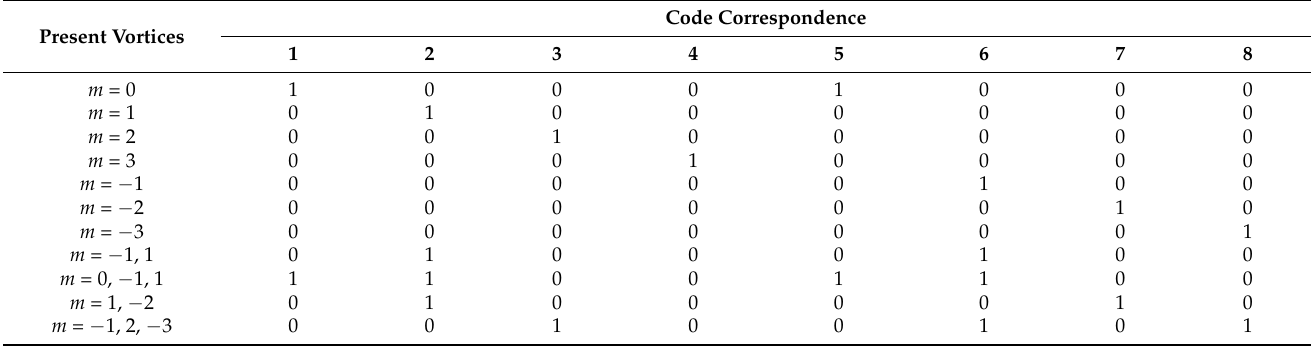
Table 1. Code correspondence of diffraction order numbers to the presence of phase vortices in the analyzed beam for a homogeneous polarization state.